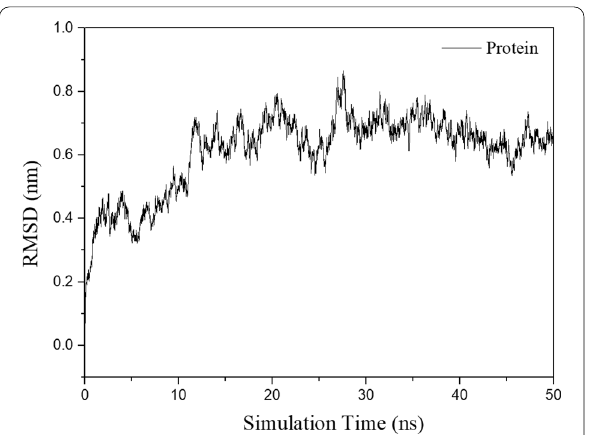
Fig. 8 Protein–ligand interactions of MT‑CalB with Chaulmoogric acid